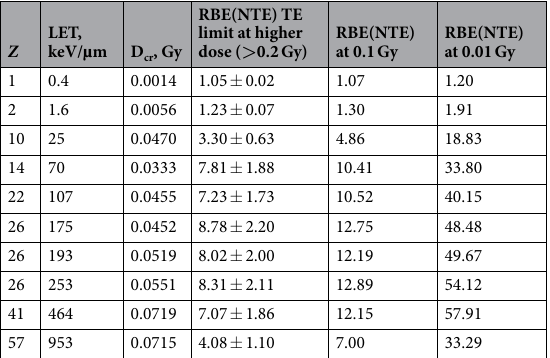
Table 2. Estimates of Relative Biological Effectiveness (RBE) at different doses, cross-over dose, Dcr, defined as where the NTE and TE terms in Equation (12) are estimated to be equal. The RBE(NTE) is relative to a linear response at higher doses (~1 Gy) of acute γ